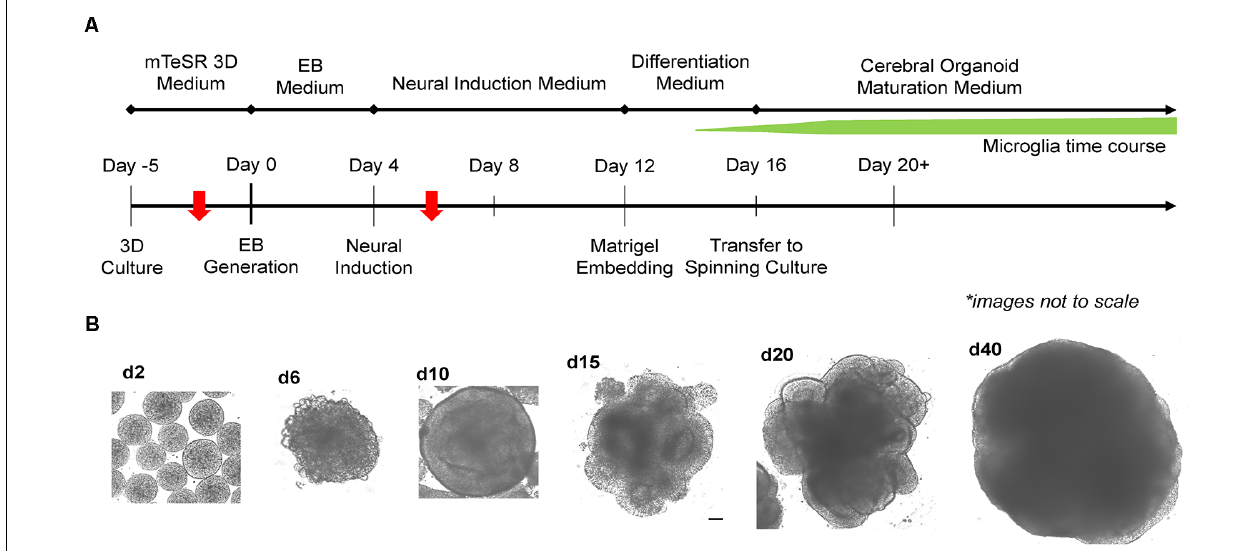
FIGURE 2 | Experimental timeline for generation of microglia-containing cerebral organoids (MCOs) and representative images for each stage of MCO formation and maturation. (A) Schematic diagram for MCO generation from iPSC 3D culture. The red arrows indicate two key steps (EB initiation and innate microglia induction). (B) Representative phase-contrast images of MCOs at various stages of growth and maturation.